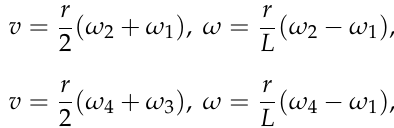
Figure 24. The 3D model of the mobile robot in Simulink Simscape. ( a ) Top view. ( b ) Isometric view. ( c ) Lateral